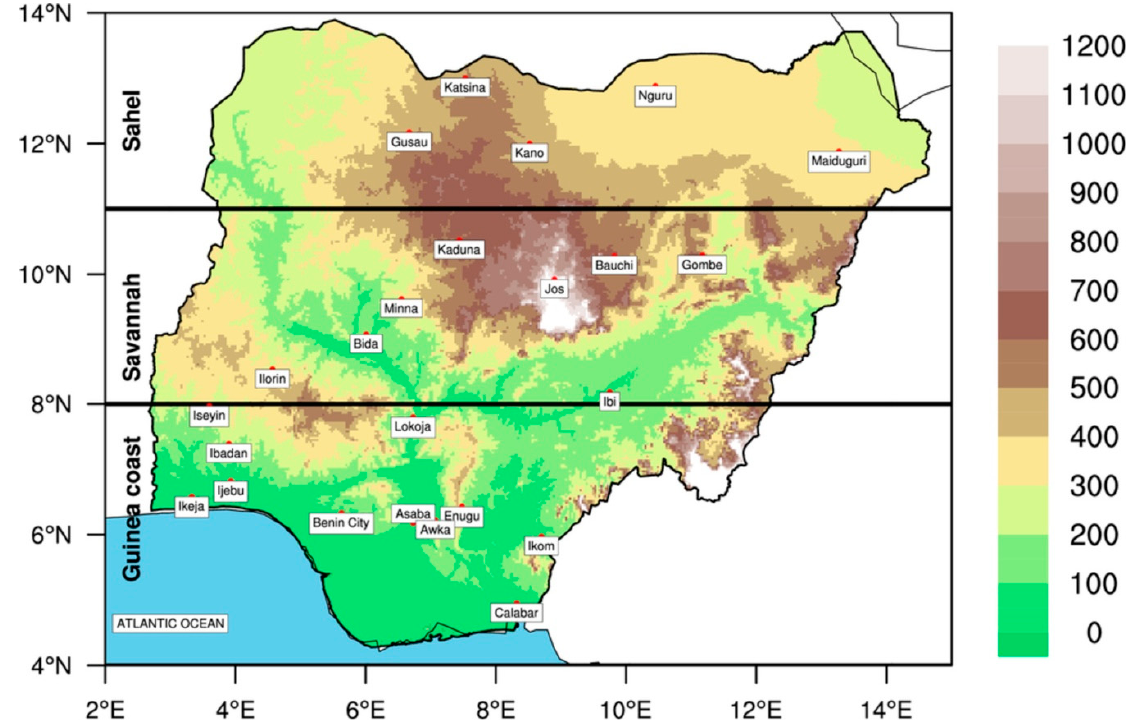
Figure 1. Digital Elevation Map of Nigeria (in metres above sea level) showing synoptic station locations within Guinea Coast, Savannah, and Sahel climatic zones [23].